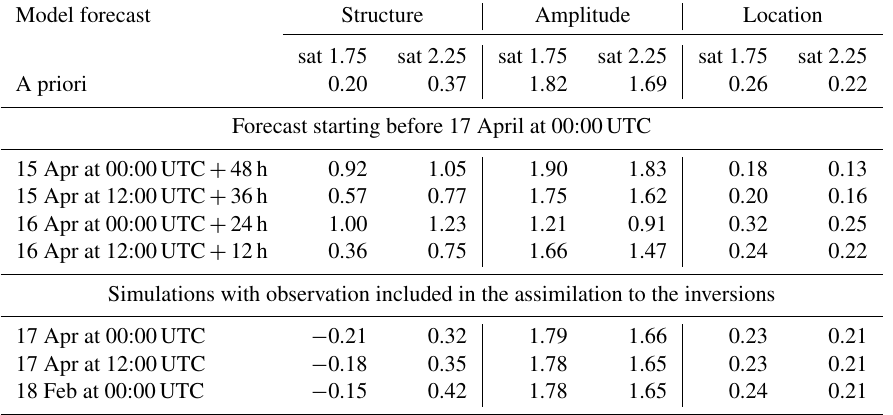
Table 2. Structure, amplitude, and location (SAL) scores (ranging from − 2 to 2 for structure and amplitude, and 0 to 2 for location; best is 0 for all) for different model simulations for comparison on 17 April at 00:00UTC using satellite retrievals (sat 1.75 and sat 2.25; see text). The model simulations that end the assimilation window before the comparison, and then use assumed forecast emission are marked as + hh hours. The last three lines correspond to simulations where the forecast starts after the observation comparison